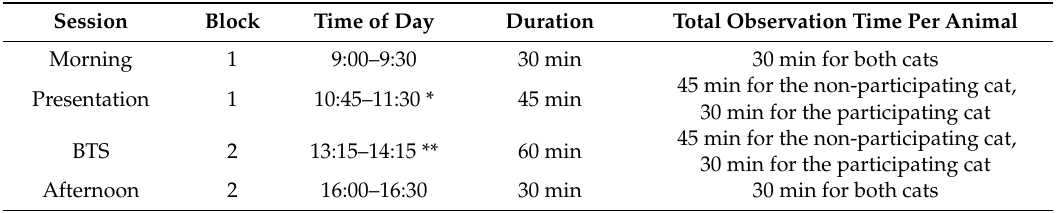
Table 2. Timeline of behavioural